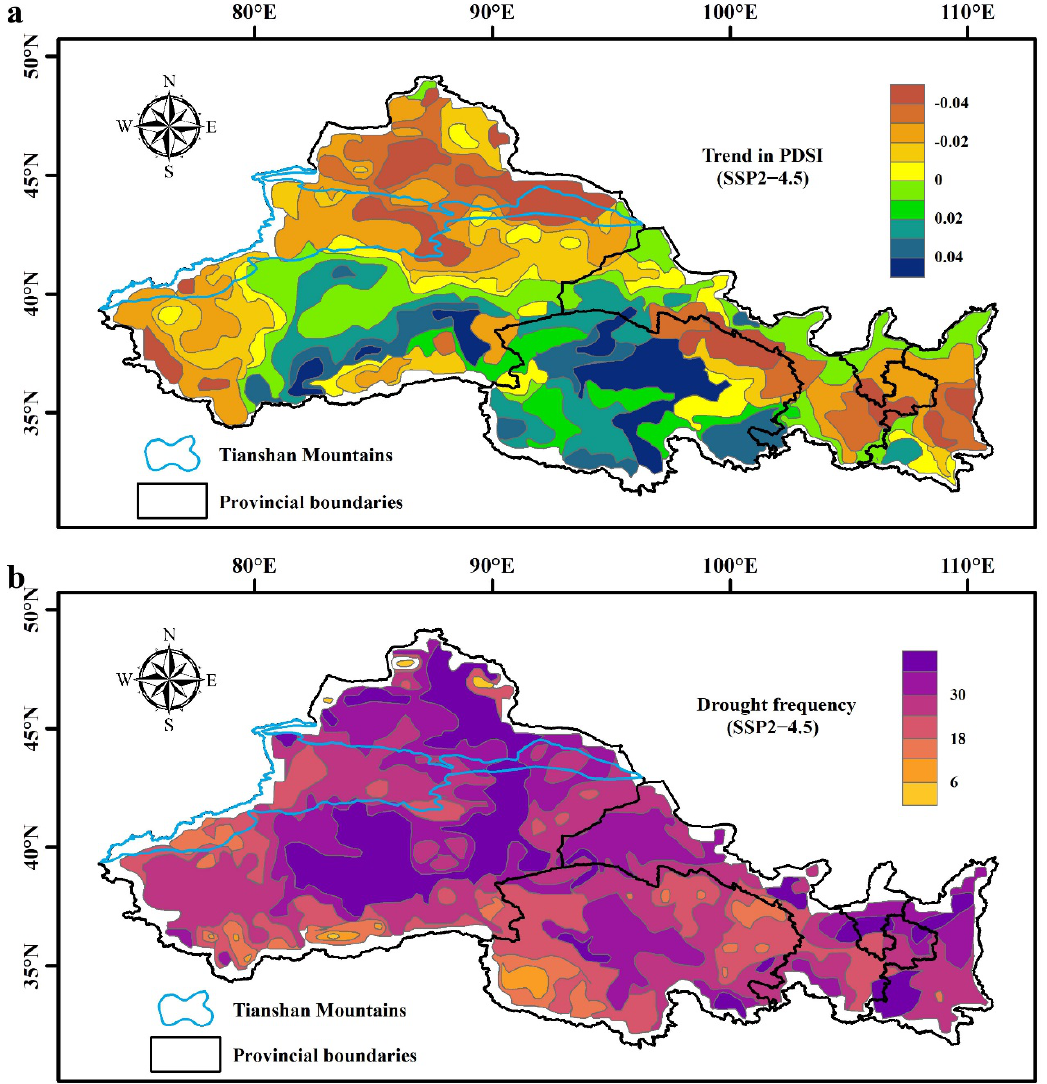
Figure 6. PDSI (Palmer Drought Severity Index) trend based on the CMIP6 model simulations in 2020–2099 [45]. ( a ): spatial distribution of PDSI trends in Northwest China under SSP2-4.5 (per year). ( b ): spatial distribution of frequency of drought events in Northwest China under SSP2-4.5 (number of drought events per 100 years).